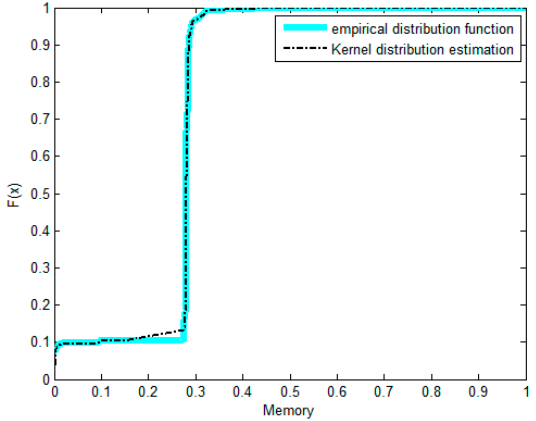
Figure 7. Density function of flow.